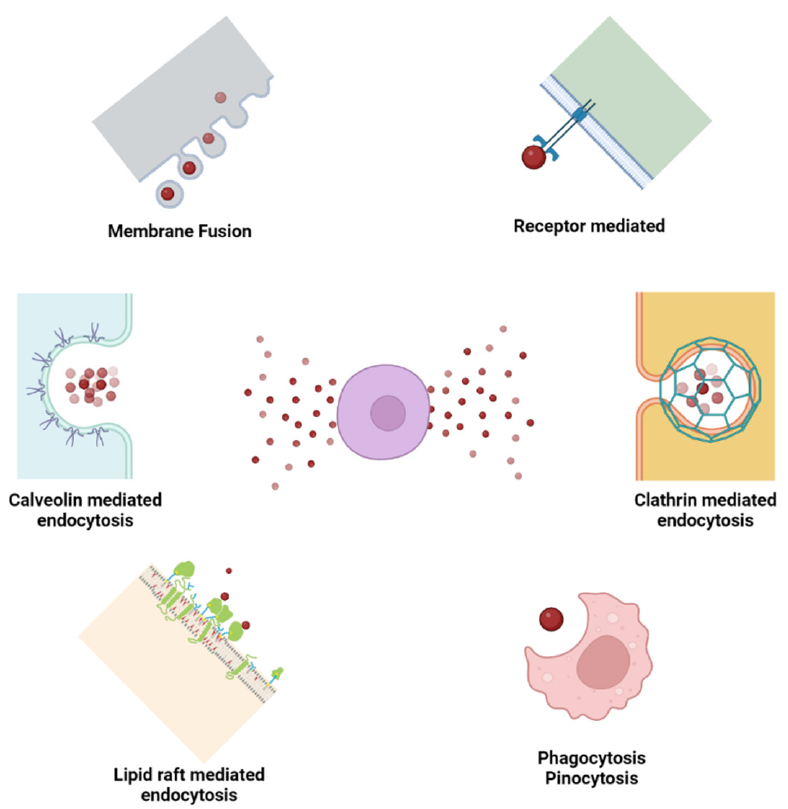
Figure 4. The mechanisms underlying exosomes uptake by target cells (adopted from [14]).